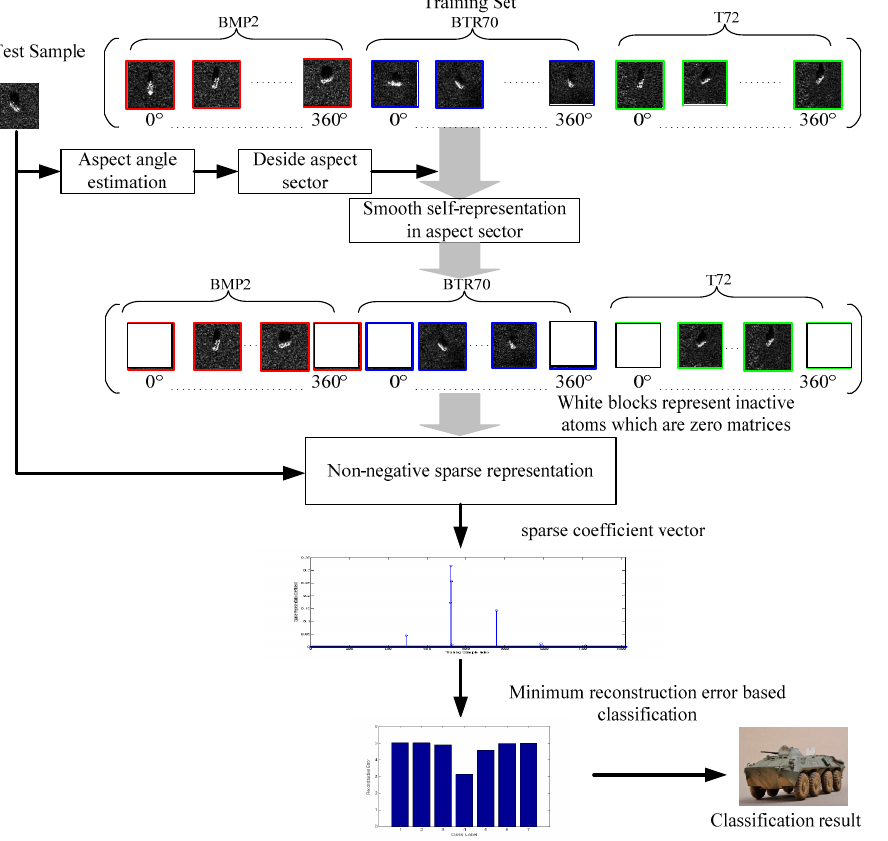
Figure 3. Flowchart of microwave image recognition based on aspect-aided dynamic non-negative least square sparse representation.